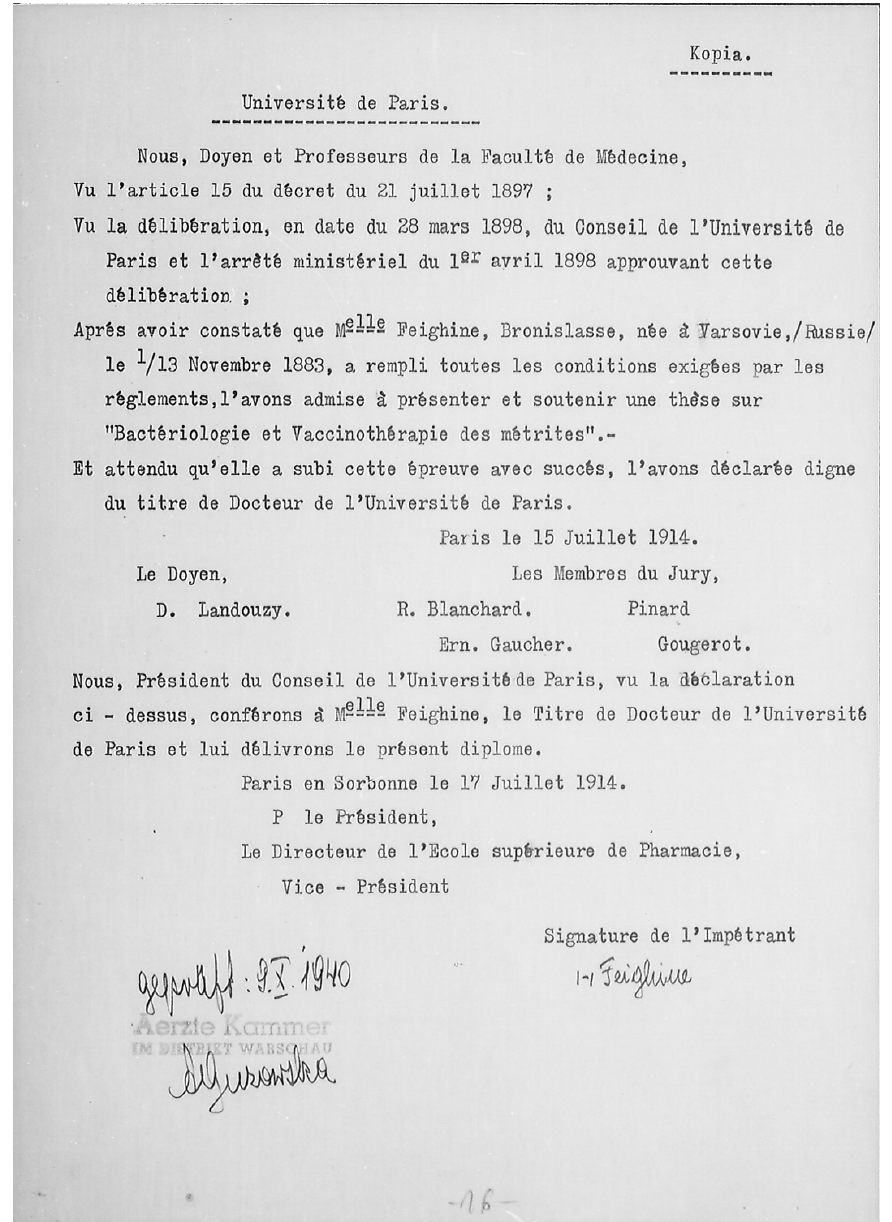
Figure 3. Copy of Bronislawa Fejgin’s French diploma. Source: Main Physicians Library, Warsaw, Poland (public domain).